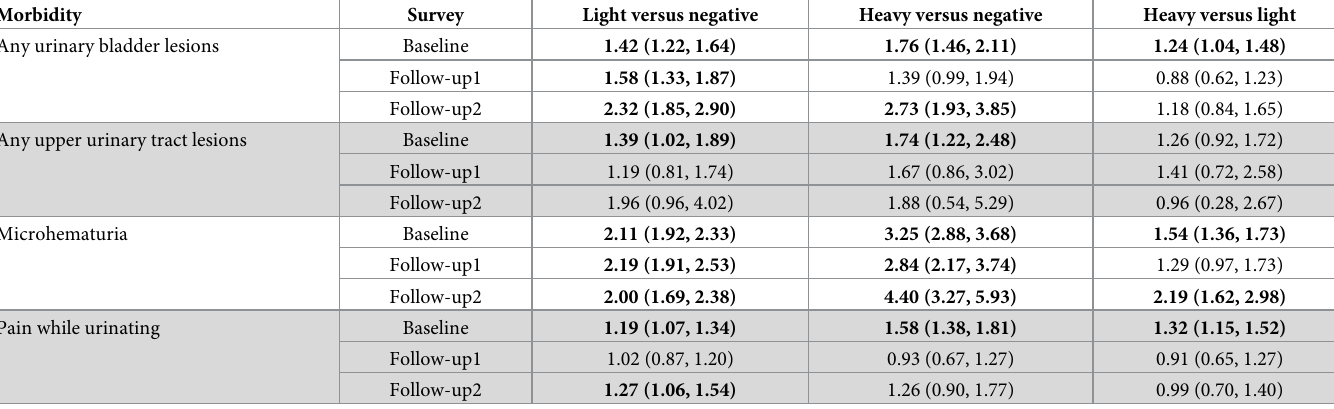
Table 2. Odds ratios (ORs) and 95% credible intervals from Bayesian logistic regression models comparing morbidity positive proportions between intensity cate- gories within surveys for S . haematobium -related morbidities. Bold font indicates the 95% Bayesian credible interval (BCI) does not contain one. Participants are school-age children (6–15 years), enrolled between 2003 and2008 in Mali, Niger, and Tanzania.